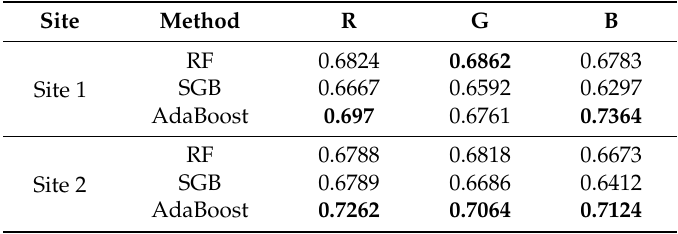
Table 9. Comparison of CBPD of fused KOMPSAT-5 image through RF, SGB, and AdaBoost.